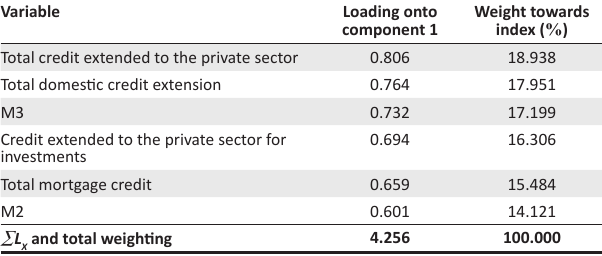
TABLE 2: Component loadings of South African credit